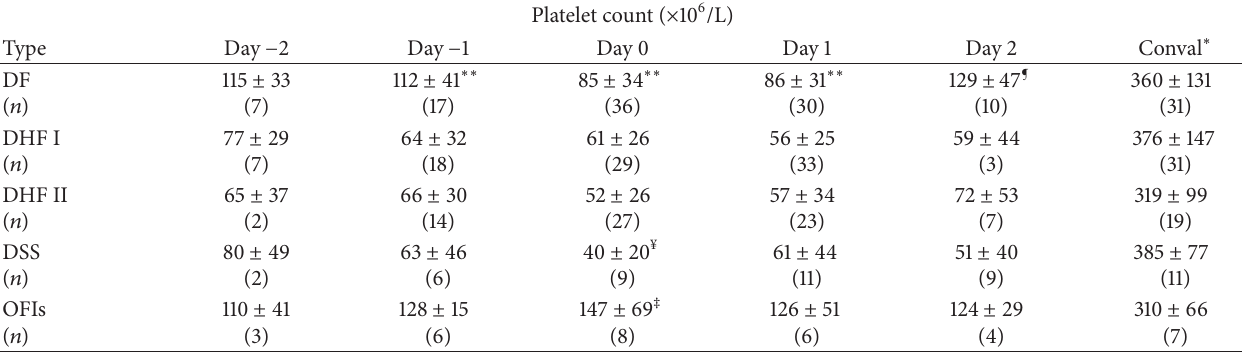
Conval ∗ = Convalescence.